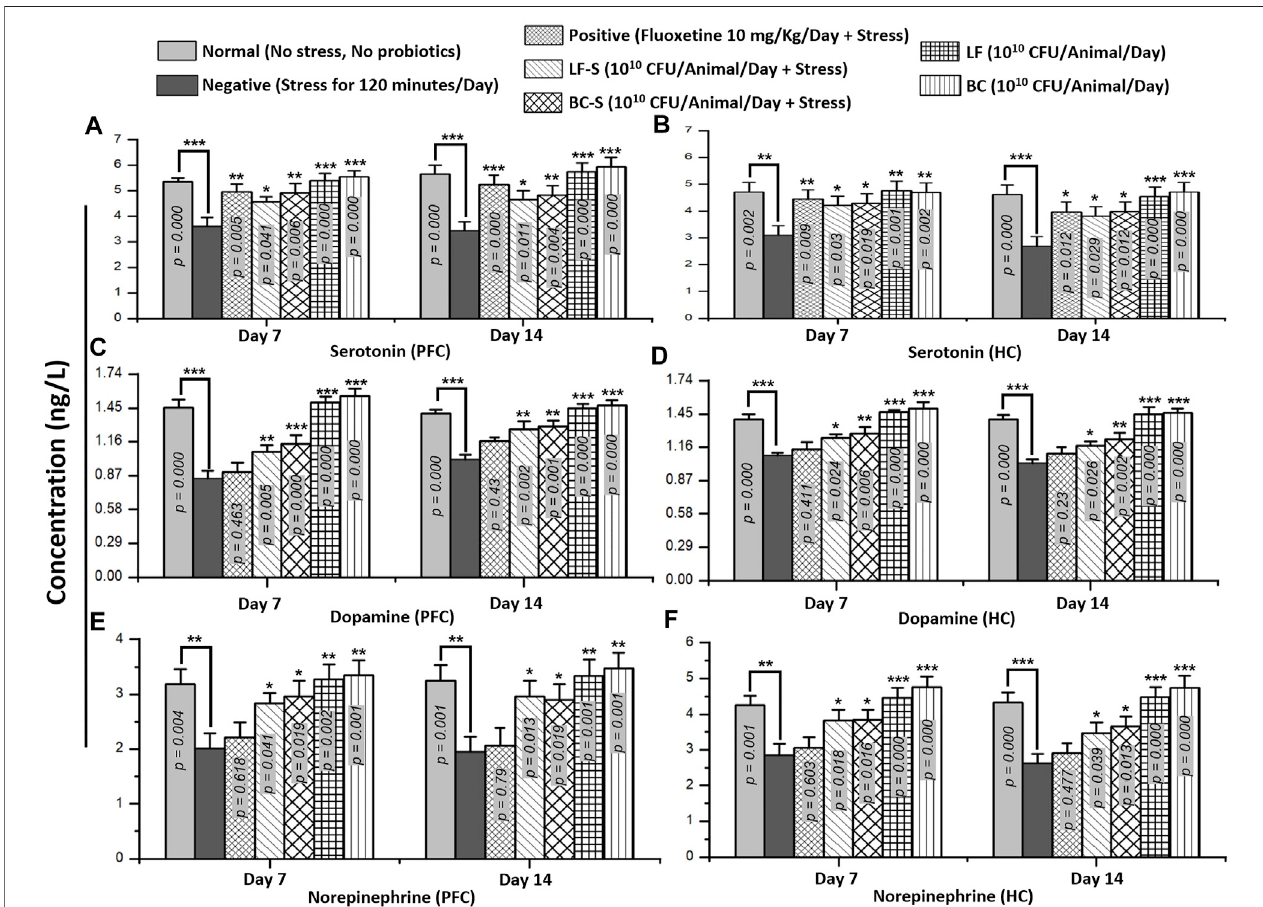
FIGURE 5 | Effects of Lactobacillus fermentum NMCC-14 and Bacillus clausii on monoamine levels (serotonin, dopamine, and norepinephrine) in the prefrontal cortexandhippocampusofacuteandsubacuterestraint-stressedandnormalmice.Comparedtothenegativegroup( n =5/group),asigni fi cantincreaseinPFCandHC monoaminelevels — serotonin (A,B) ,dopamine (C,D) ,andnorepinephrine (E,F) — wasshowninLF-SandBC-Sgrouprestraint-stressedmice.Compared tothenormal group ( n =5/group), nosigni fi cant( p < 0.05) change wasobserved inmonoamine levels — serotonin (A,B) , dopamine (C,D) , and norepinephrine (E,F) — inthe PFC andHCofLFandBCgroupmice.Valuesexpressedaremean±standarderrortothemean(SEM).Notethat # p =0.05,* p < 0.05,** p < 0.01,and*** p < 0.001versusthe negative group by applying two-way ANOVA.